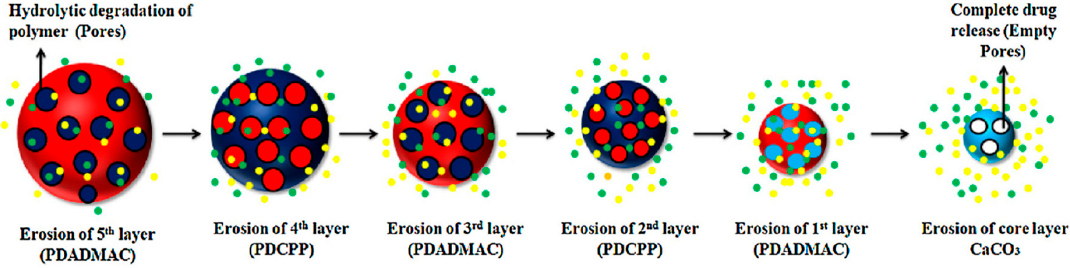
Figure 10. Schematic illustration of the hydrolytic degradation of PDADMAC)/PDCPP) multilayers, leading to the release of both cisplatin and chrysin. Schematic taken with permission from Reference [107], copyright© 2018, Elsevier.